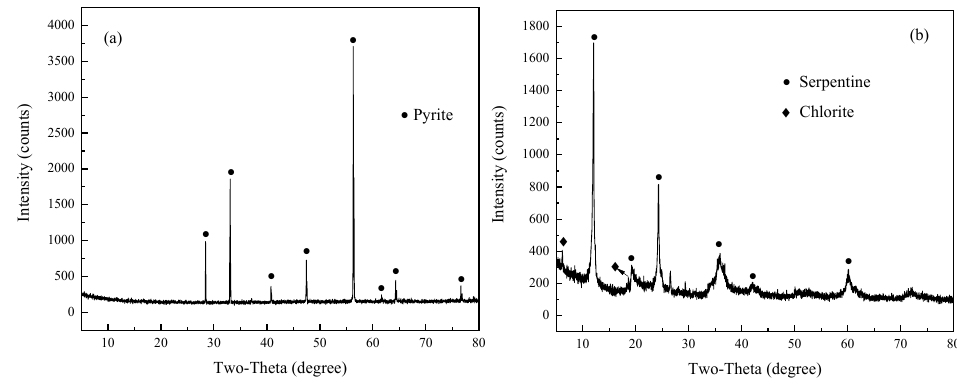
Figure 2. XRD patterns of ( a ) pyrite and ( b ) serpentine